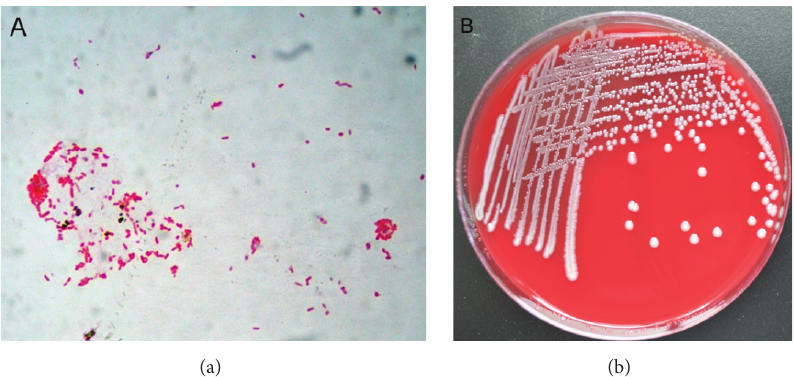
Figure 1: Gram staining and morphology of R. terrigena Z38 colony. (a) Gram-negative, short-rod-shaped bacterium was observed (magnification, × 100). (b) Shown are circular, smooth, glistening, light yellow, and nonhemolysis colonies after a 48-hour culture on sheep blood agar under aerobic conditions.